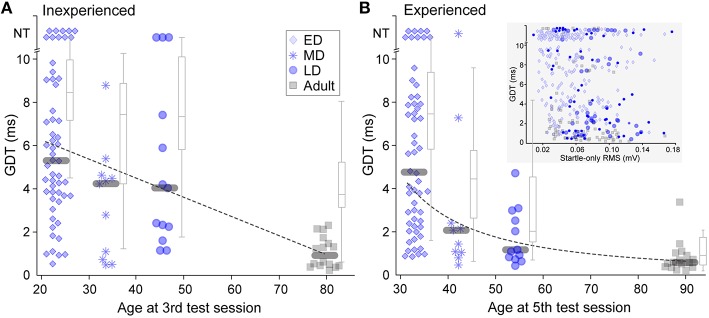
Gap detection development with and without gap-PPI experience. (A) Symbols depict best GDT and gray boxplots depict average GDT across sessions 1 through 3, providing a representation of inexperienced thresholds. NT = no threshold, indicating that the longest gap presented (10 ms) was not detected. (B) Symbols depict best GDT and gray boxplots depict average GDT across sessions 4 and 5, providing experienced thresholds. The improved thresholds in MD and LD groups show improvement based on experience. Gray bars depict median values. (Inset) Scatterplot for all age groups of the relationship between startle-only magnitudes and gap detection thresholds across age groups. There was no significant correlation. For boxplots, central mark is the median, edges are 25th and 75th percentiles, and whiskers extend to the most extreme data points excluding outliers.